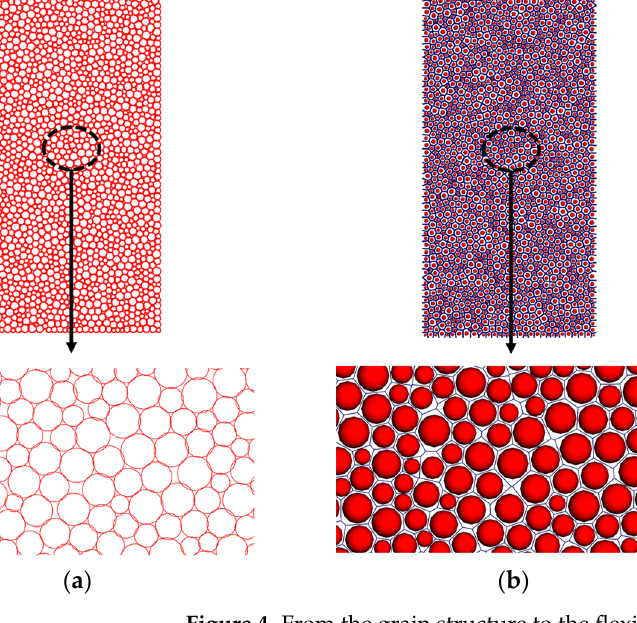
Figure 4. From the grain structure to the flexible contact model: ( a ) initial grain structure; ( b ) rigid contact model based on the Voronoi tessellation [14]; ( c ) propose flexible particle model, including the inner FE mesh.